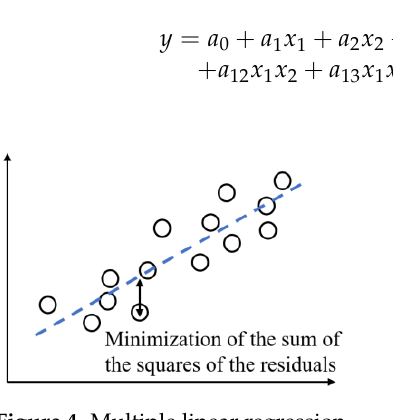
Figure 5. Decision tree.